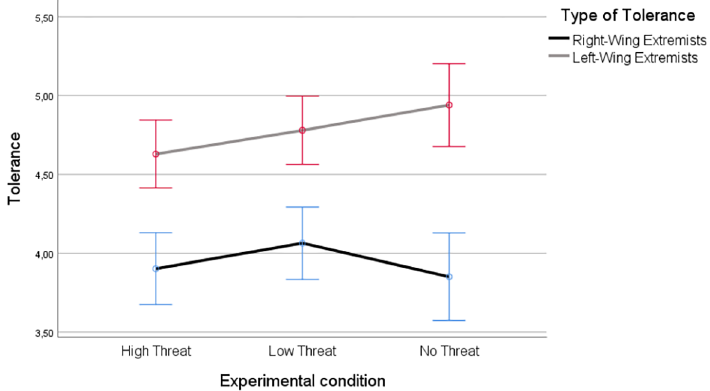
Note. Error bars represent 95% CI. Left-right ideological self-placement is included as a